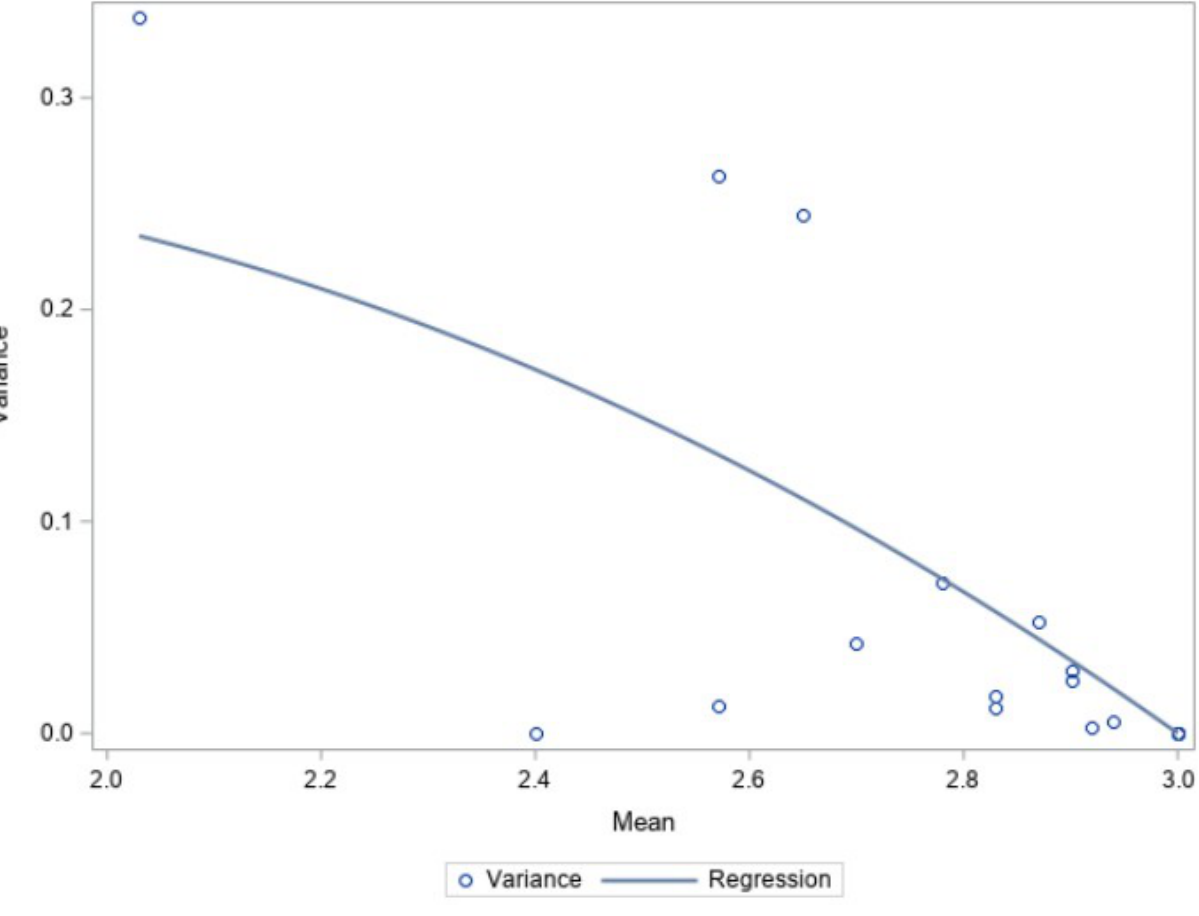
Figure A1. Variance plotted against mean for the scores given for internal inspector